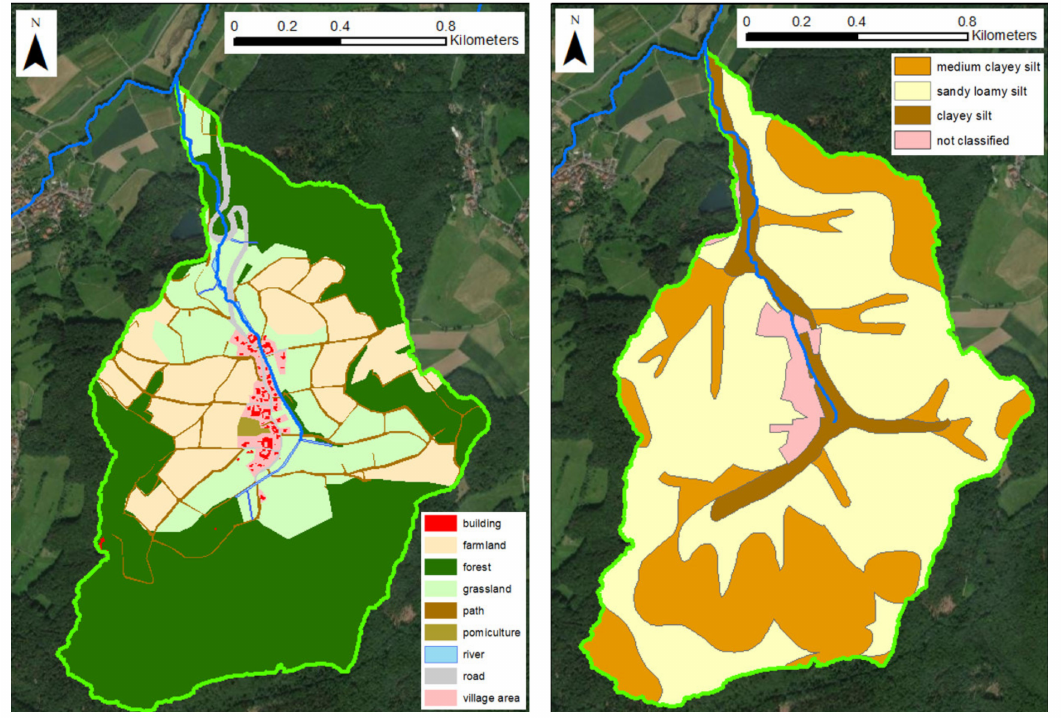
Figure 4. Map of land-use and soil data in the Messbach